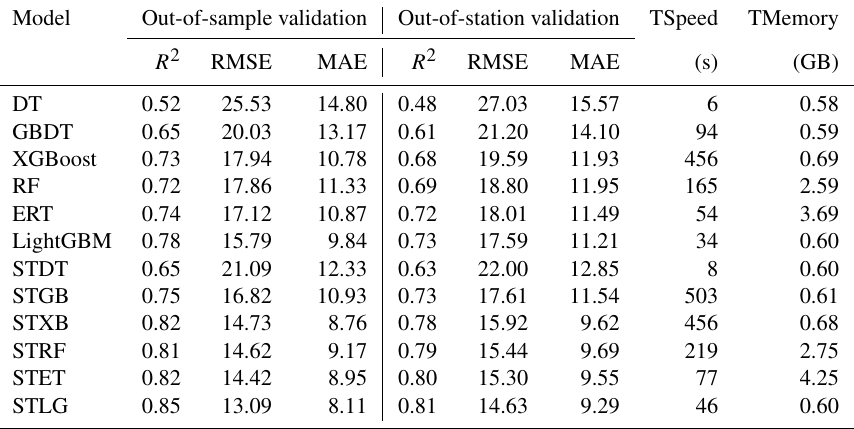
Table 5. Comparison of the model performances of different tree-based machine-learning models and the STLG model using the same input data. Data are from 14:00LT in 2018 in China ( N = 162840). TSpeed and TMemory refer to the speed and memory consumption during the model training.